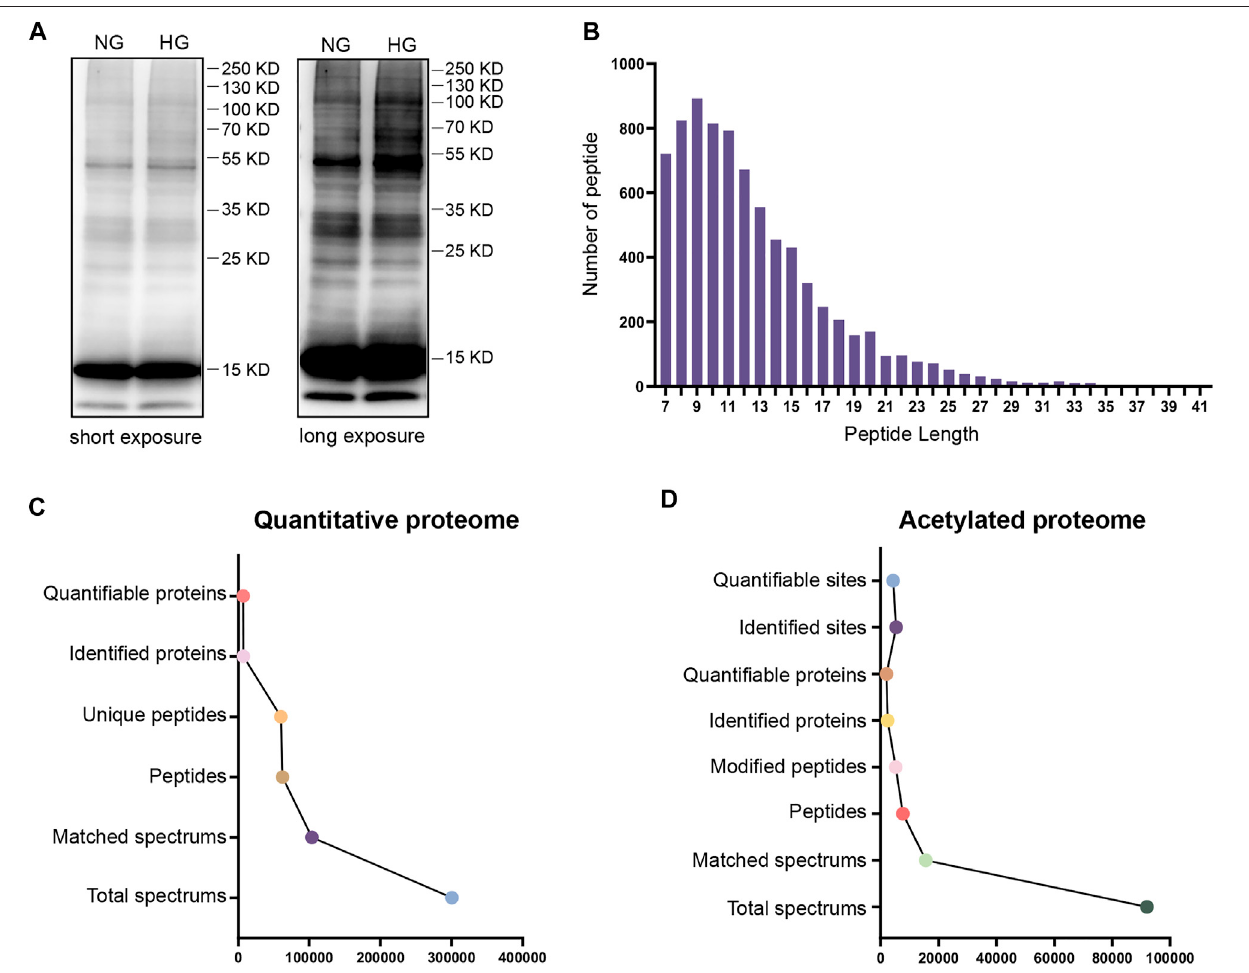
FIGURE1| Analysisoftheglobalproteomeandacetylatedproteome. (A) WesternblottingofproteinsinTKPTcellswithanti-lysineacetylationantibodies.Thetwo lanes represent NG (normal glucose: 5.6 mM) and HG (high glucose: 40 mM) conditions. Short exposure and long exposure, respectively. (B) The distribution of acetylated proteins based on the number of acetylation sites. (C) The global proteome was searched and analyzed in a MS/MS mass spectrometry database. (D) The acetylated proteome was searched and analyzed in a MS/MS mass spectrometry